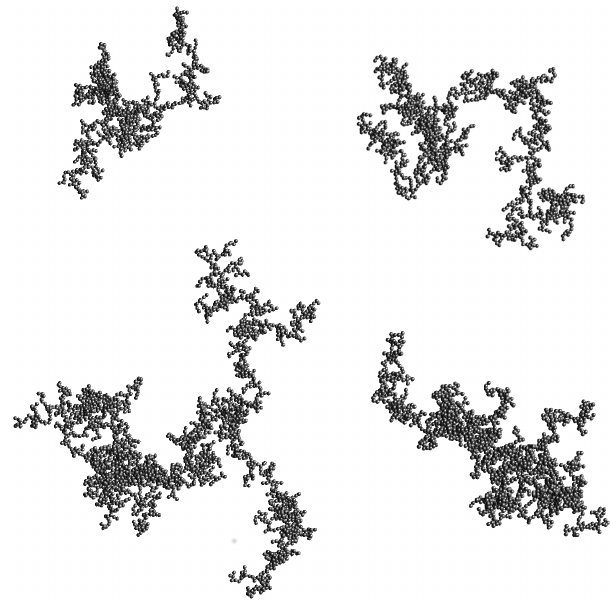
Figure 1. Examples of fractal aggregate model particles for com- puting optical properties of externally mixed black carbon. The ag- gregates consist of 1000, 1500, 2000, and 2744 monomers (in clock- wise order, starting from upper